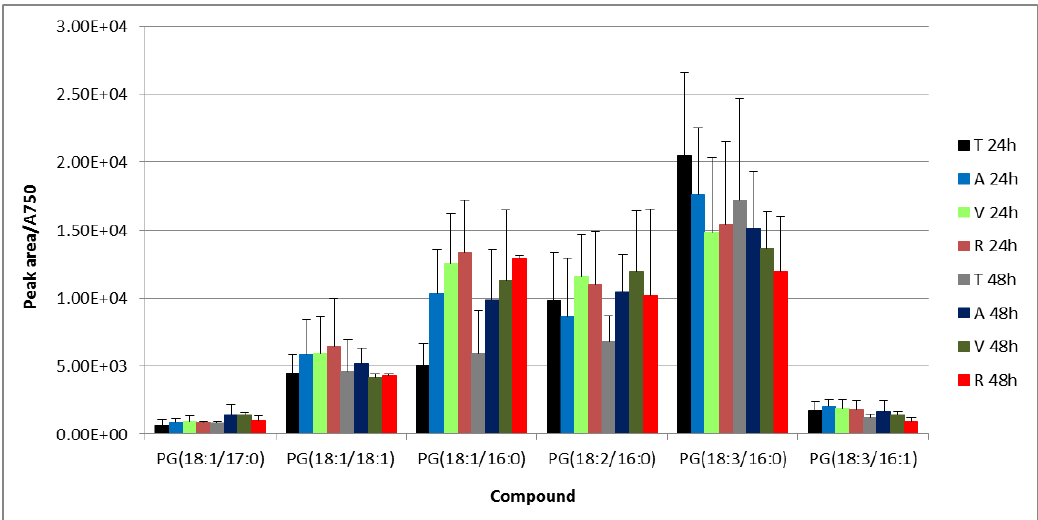
Figure 2. Relative content normalized to the absorbance at 750 nm of the monogalactosyldiaylglycerol (MGDG) species, digalactosyldiacylglycerol (DGDG) species, sulfoquinovosyldiacylglycerol (SQDG) species, and phosphatidyldiacylglycerol (PG) species as measured by UPLC-MS with positive (MGDG and DGDG) or negative (SQDG and PG) electrospray ionization from a methanolic extract of Synechococcus sp. cells. Glycerolipid nomenclature used in this study is that recommended by the LipidMaps consortium (http://www.lipidmaps.org/), where the acyl chains esterifying the sn -1 and the sn -2 positions of the glycerol backbone are located in the first and second places within the brackets ( sn -1/ sn -2), and the polar head group (phosphatidylglycerol, sulfoquinovosyl, galactosyl and digalactosy) is assumed to esterify the sn -3 position of the glycerol backbone.